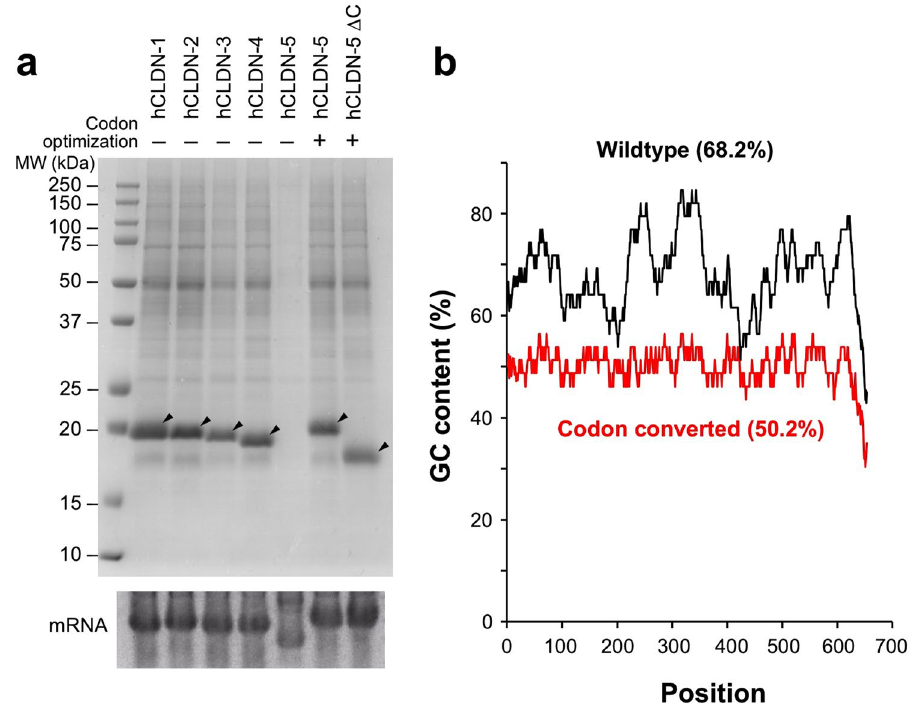
Figure 1. Cell-free synthesis of CLDN-5 with codon-converted mRNA. ( a ) Cell-free synthesized human CLDNs. Human CLDN-1 through CLDN-5 were synthesized on asolectin liposome using the wheat cell- free system with bilayer-dialysis method. After translation, proteoliposomes were purified by repeated centrifugation and resuspension in buffer. Upper panel: purified proteoliposome was subjected to SDS-PAGE and synthesized CLDNs were visualized by CBB staining. Arrowheads indicate translated CLDNs. Lower panel: gel electrophoresis of CLDN mRNAs. In vitro transcribed mRNA was applied to gel electrophoresis under non-denaturing conditions. ( b ) GC content of wild-type and codon-converted human CLDN5 mRNAs. The plot indicates local GC content, calculated by averaging 20 bases before and after each position. Figures in